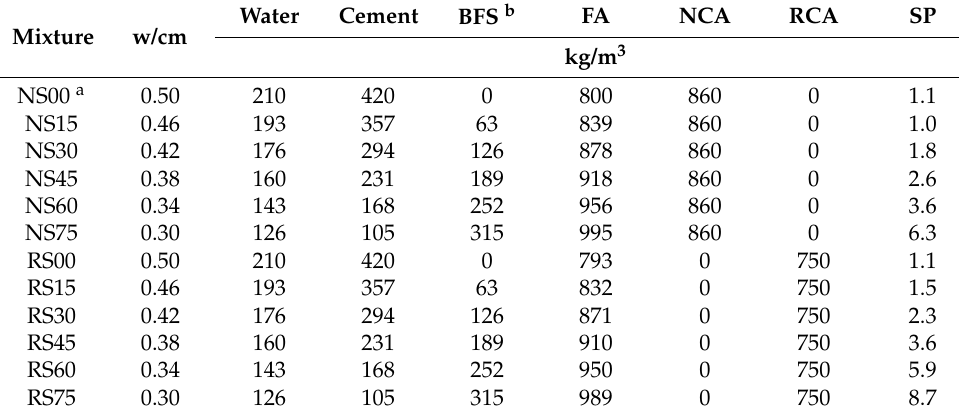
Table 2. Proportions of concrete mixtures.